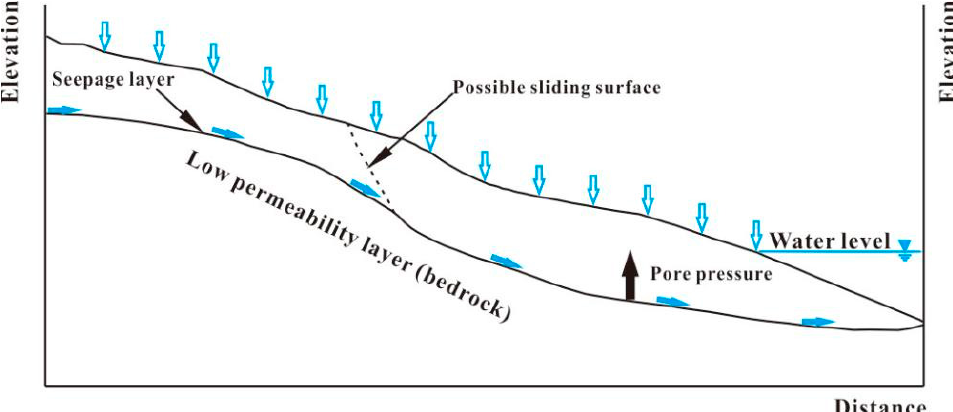
Figure 19. Conceptual model of a chair-shaped bedrock landslide under the conditions of lowering water levels and rainfall.